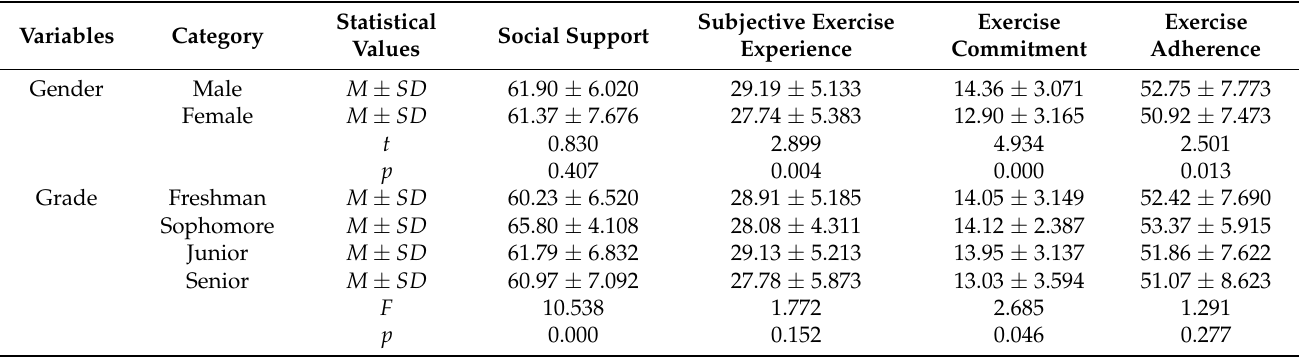
Table 1. Descriptive statistical results and analysis of variance of the